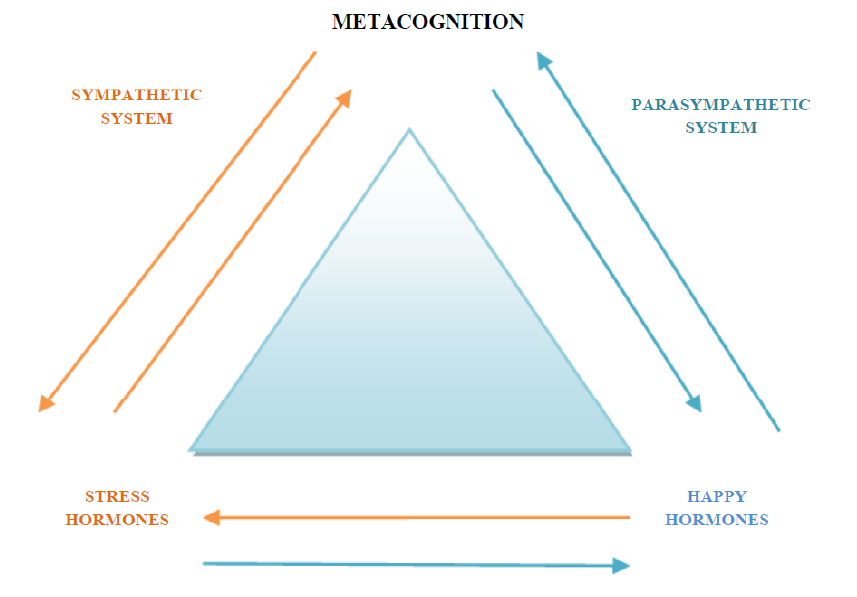
Fig. 1. Metacognition, hormones & autonomic nervous system: A triangular